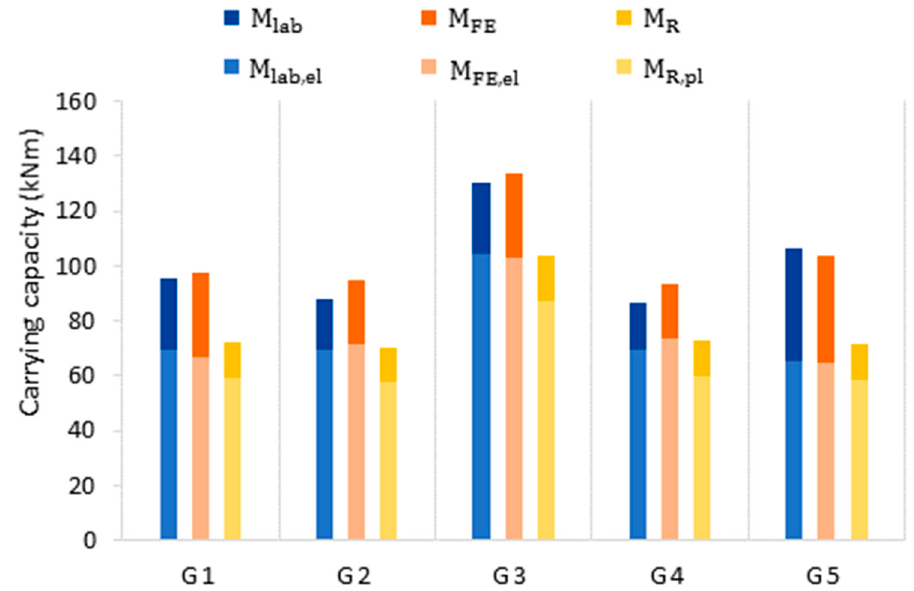
Figure 19. Comparison of the load-carrying capacity assessment in laboratory tests ( blue ), FE models of the original beams ( orange ), and analytical formulas ( yellow ).